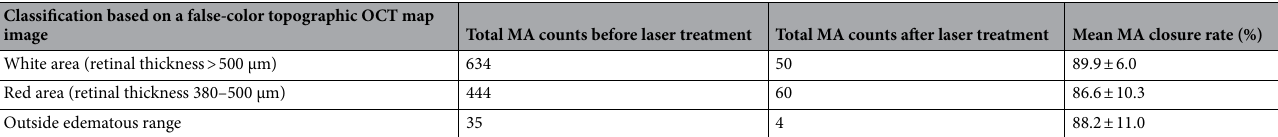
Table 2. Microaneurysm counts and the closure rate depending on the degree of edema thickness according to classification based on a false-color topographic optical coherence tomography map image. n = 11. Values are presented as means ± standard deviations. OCT, optical coherence tomography; MA, microaneurysm.